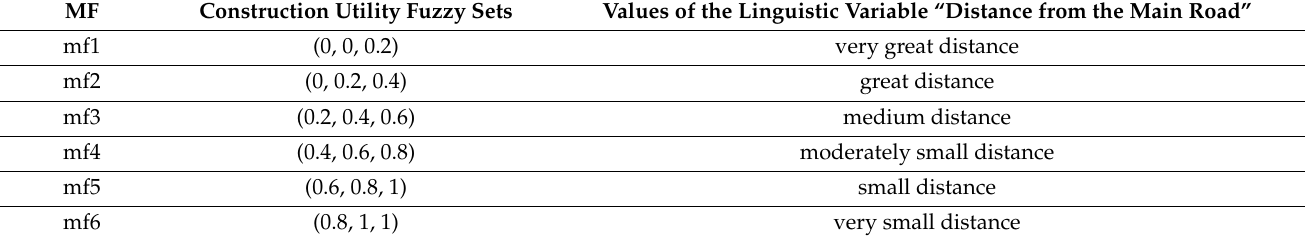
Table 6. Defining fuzzy sets and values of the linguistic variable “Distance from the main road”.